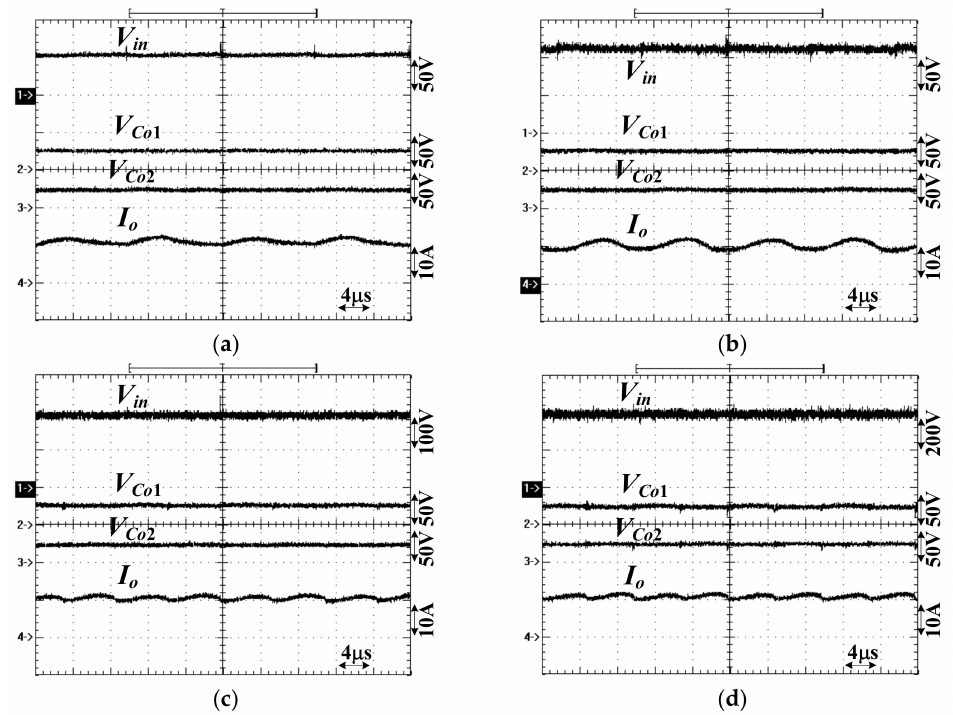
Figure 13. Measured results of V in , V Co 1 , V Co 2 and I o at 100% load: ( a ) 50 V input (low voltage range); ( b ) 110 V input (medium voltage range); ( c ) 190 V input (medium voltage range); ( d ) 400 V input (high voltage